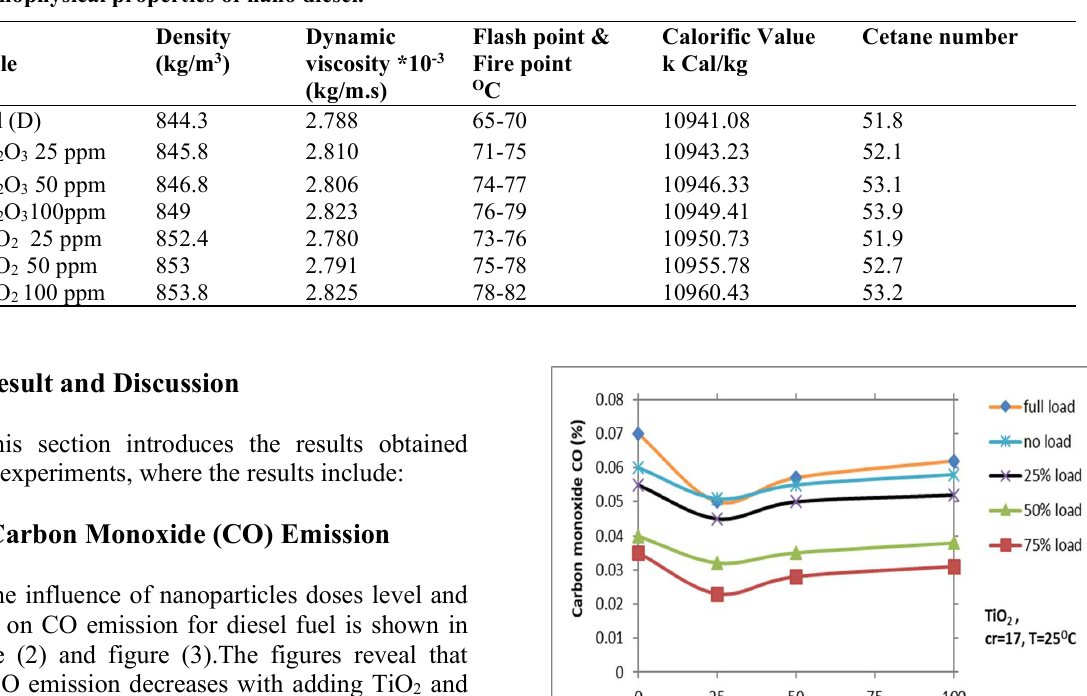
Thermophysical properties of nano diesel.